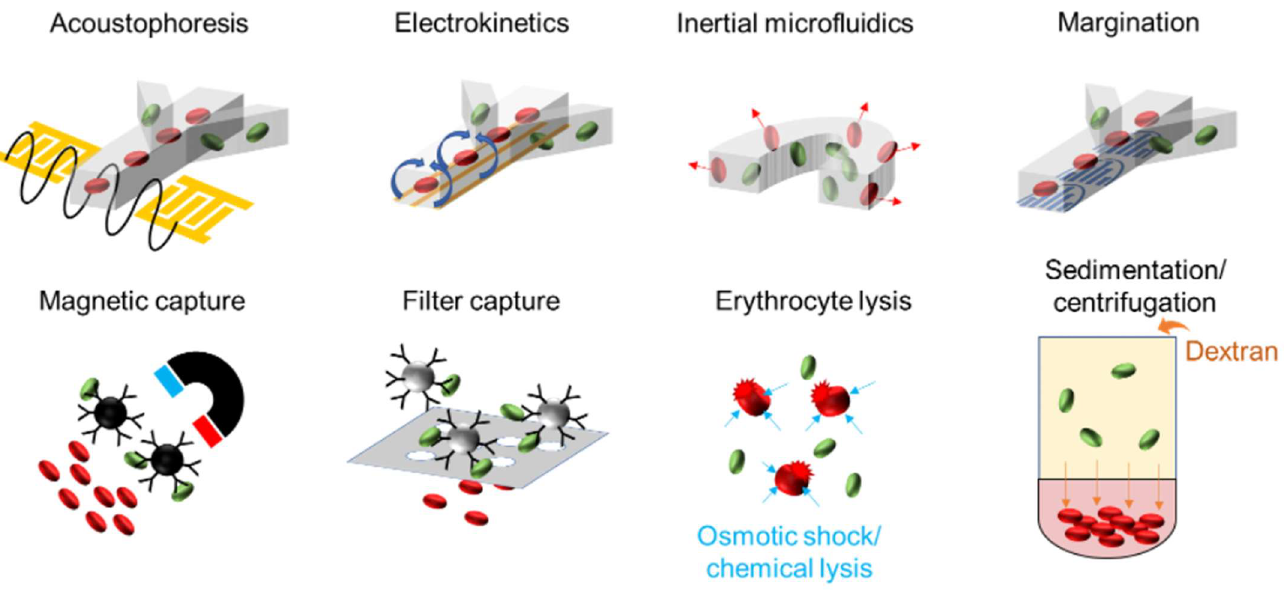
Figure 2. Sample preparation techniques for BSI diagnostics. Pathogen isolation and concentration can be achieved actively via acoustophoresis, electrokinetics, and magnetic forces, or passively via inertial focusing, margination, filtering, and erythrocyte